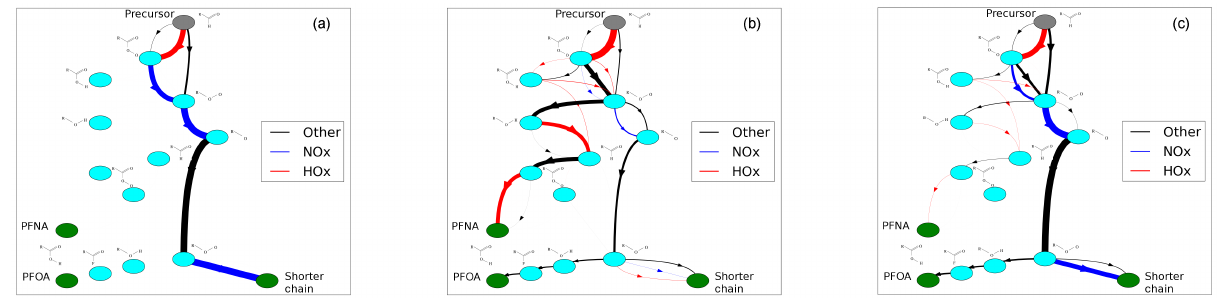
Figure 5. Total flux through each reaction for the degradation mechanism for urban (a) , ocean (b) , and Arctic (c) conditions. Each line represents a reaction, with the color of the line indicating the photochemical family of the non-fluorinated reactant, and the thickness of the line is proportional to the total flux through the reaction over the course of a